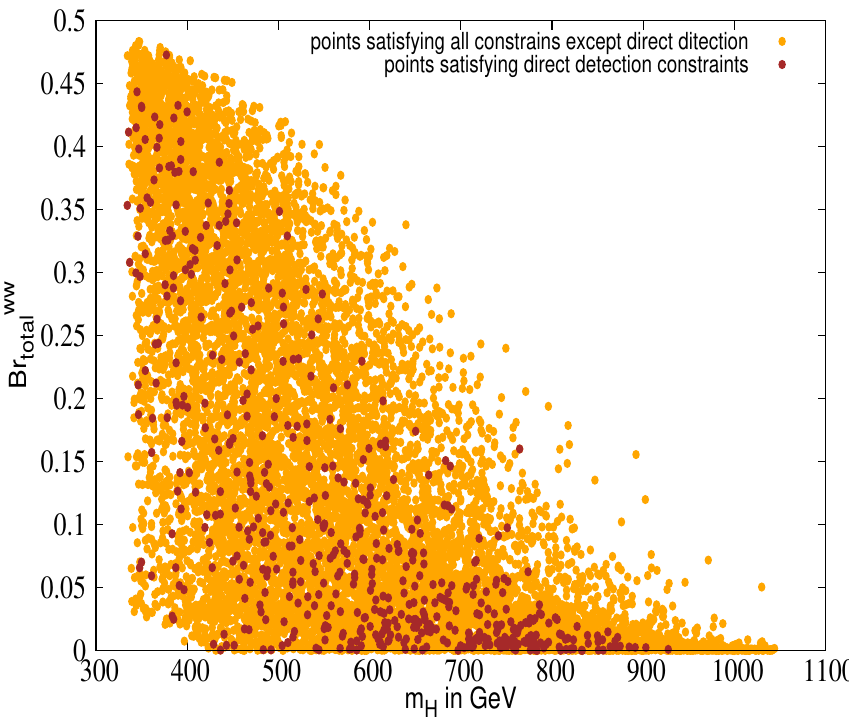
Figure 9 . m H distribution of Br WW . Orange points satisfy only relic density bounds and over and total above that the brown points satisfy the current direct detection limit coming from XENON1T.